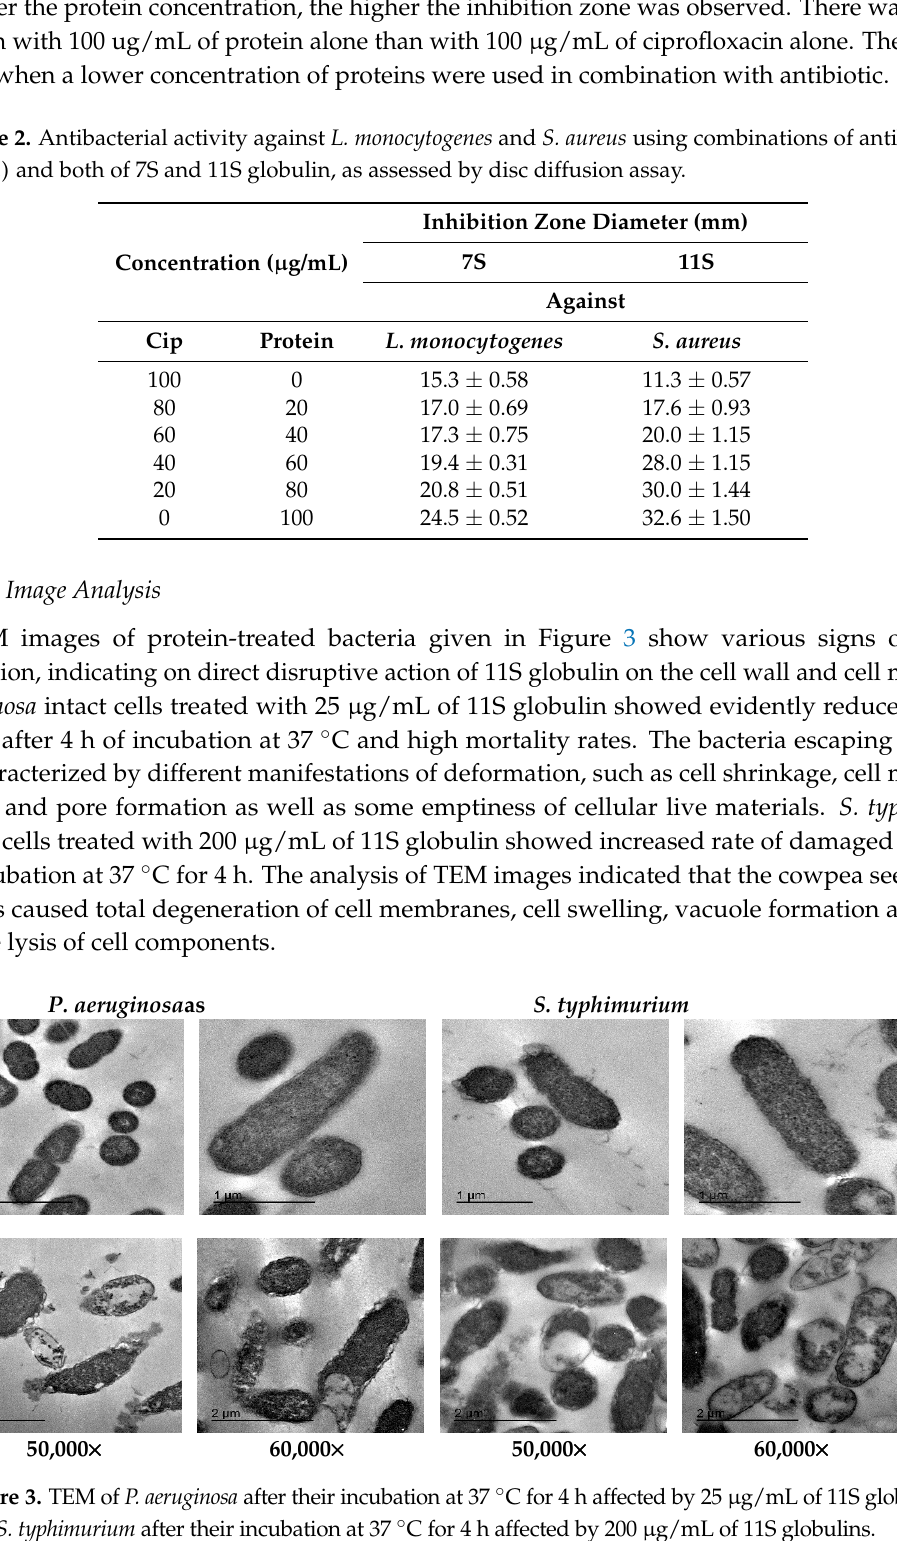
Table 2. Antibacterial activity against L. monocytogenes and S. aureus using combinations of antibiotic (Cip.) and both of 7S and 11S globulin, as assessed by disc diffusion assay.